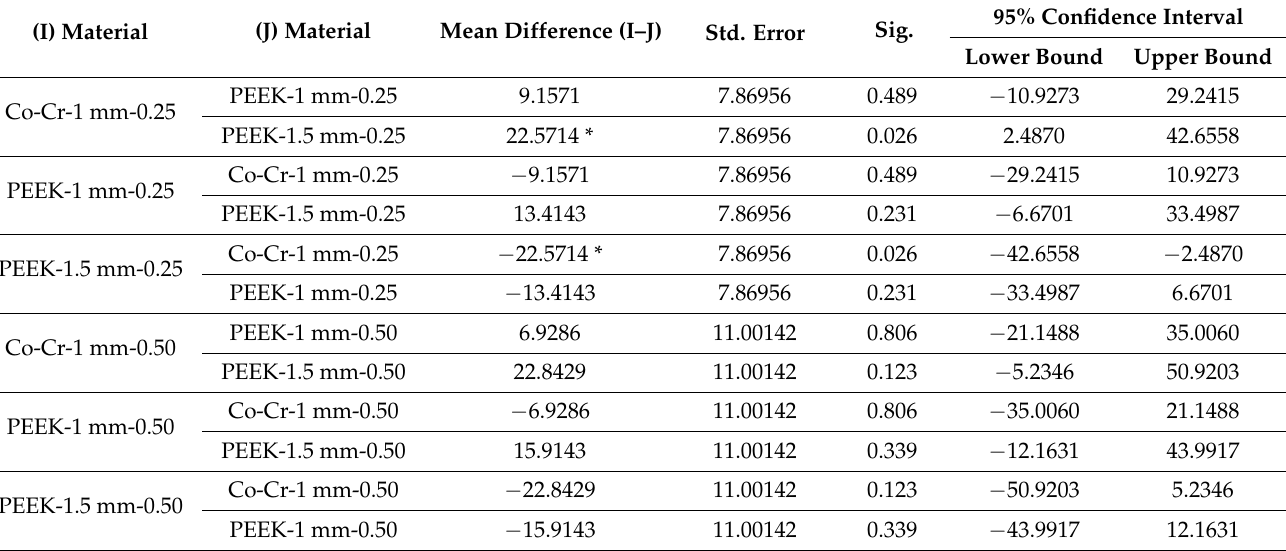
Table 8. Tukey multiple tests of clasps material at 0.25 mm and at 0.50